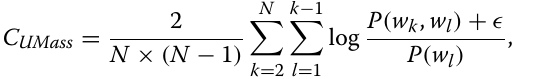
against w n , w j , cutting and weighting